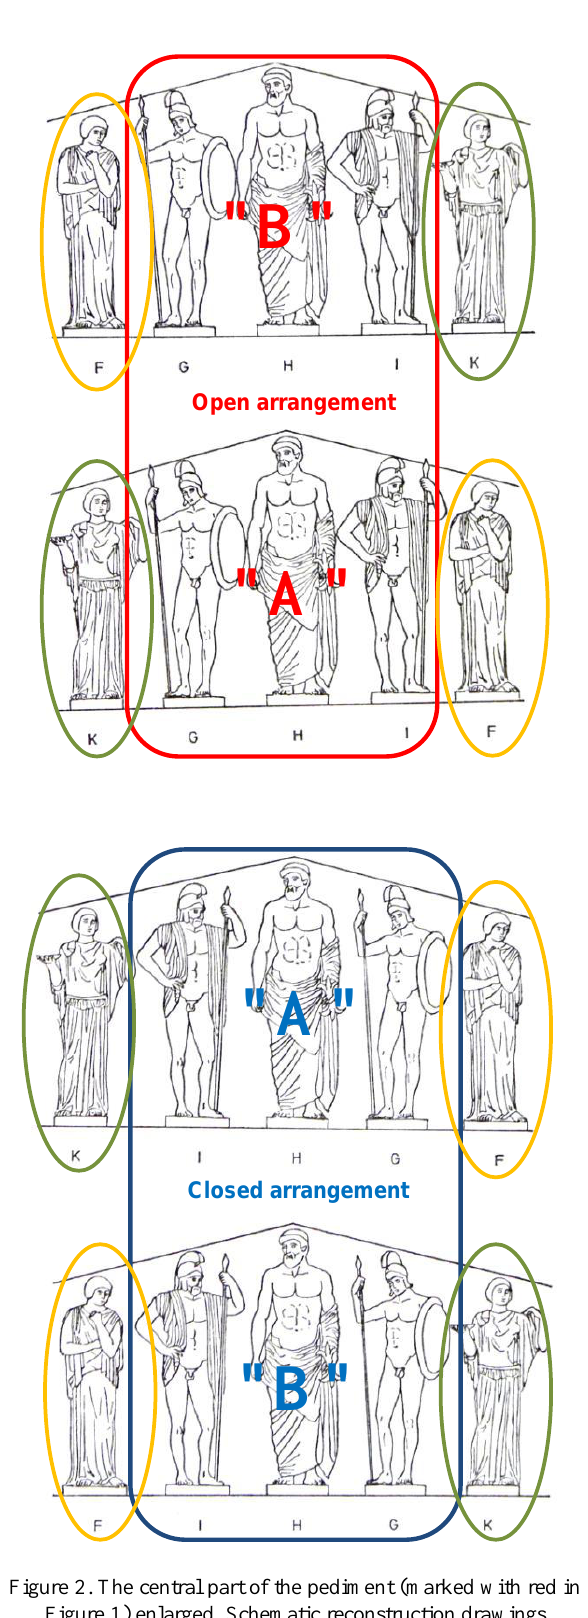
Figure 2. The central part of the pediment (marked with red in Figure 1) enlarged. Schematic reconstruction drawings showing every conceivable arrangement of the five central figures. Different colours highlight the differences of the four versions. After Herrmann